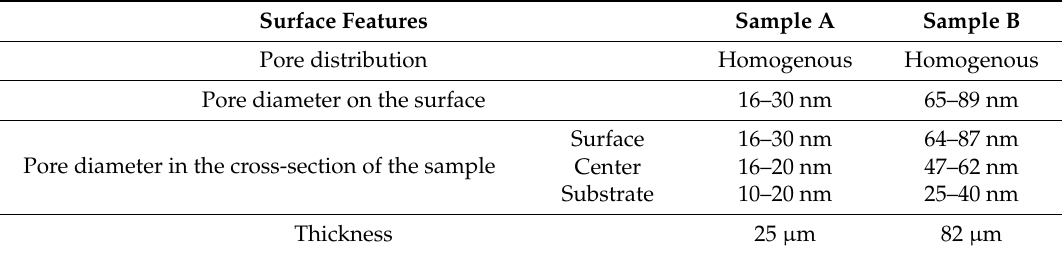
Table 1. The pore size distribution over the cross-section of the sample and on the